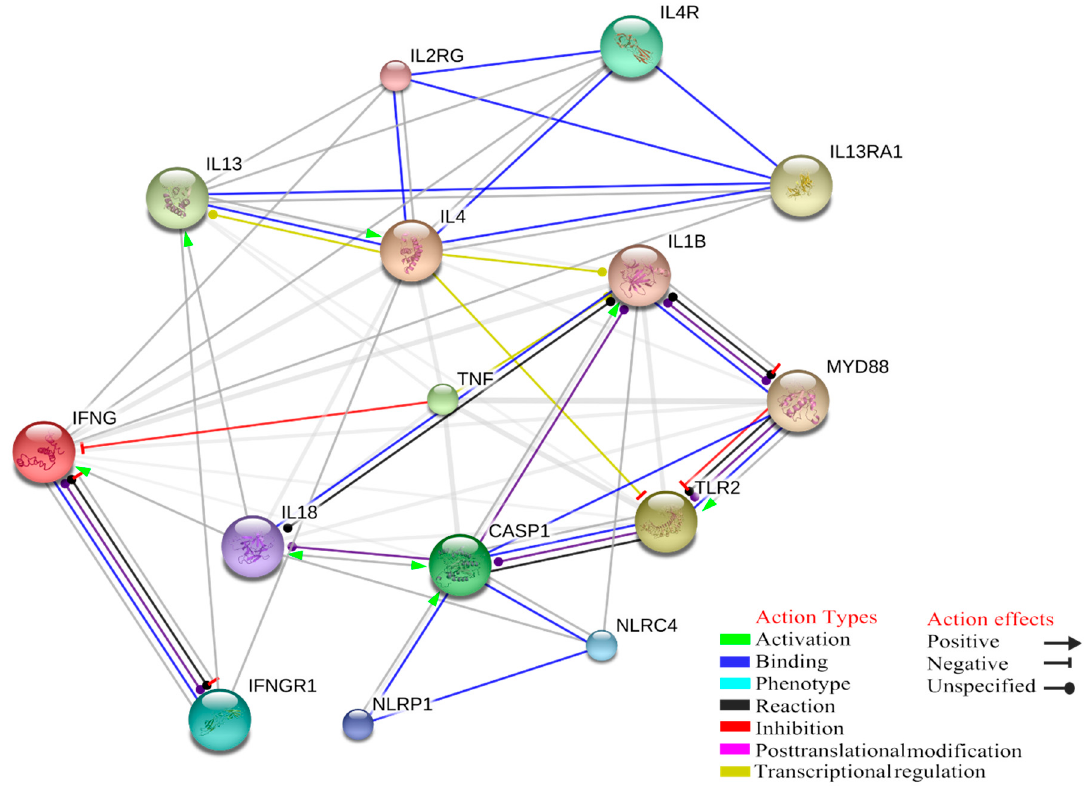
Figure 2. Interaction among IFN- γ , TLR2, CASP1, TNF α and IL-4 that may have effect on inflammasome assembly and activation during tick-borne pathogens infection.